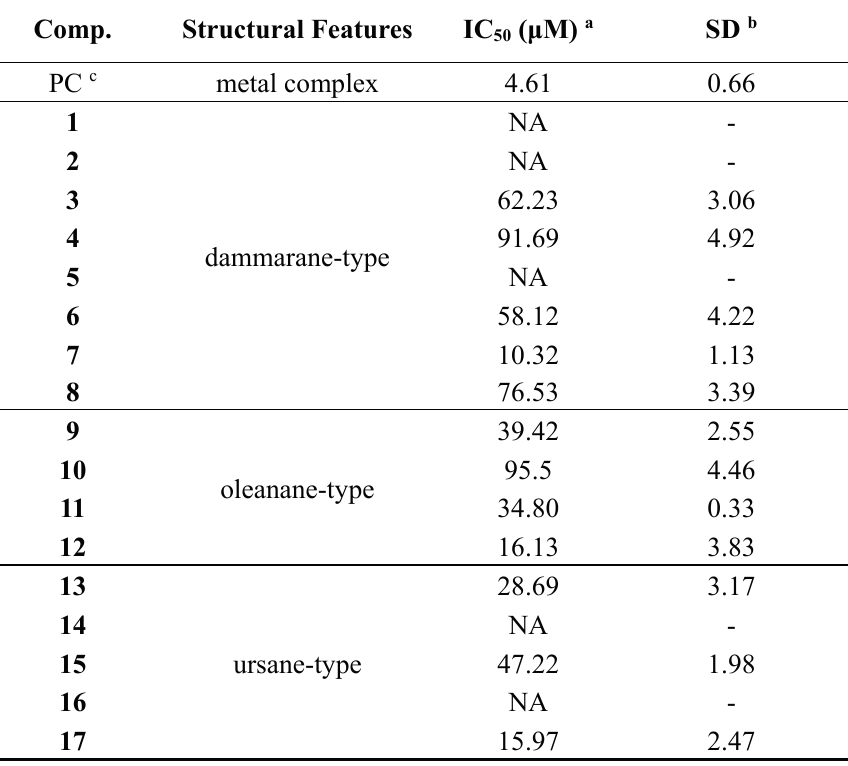
Table 2. Cytotoxicities of compounds 1 – 17 from J. mandshurica Maxim. in HepG-2 cells line.